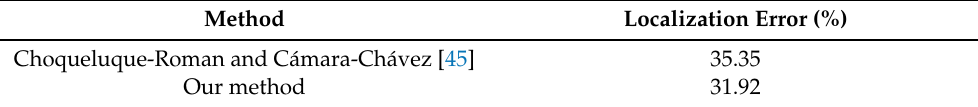
Table 5. Localization performance on UCFCrime2Local